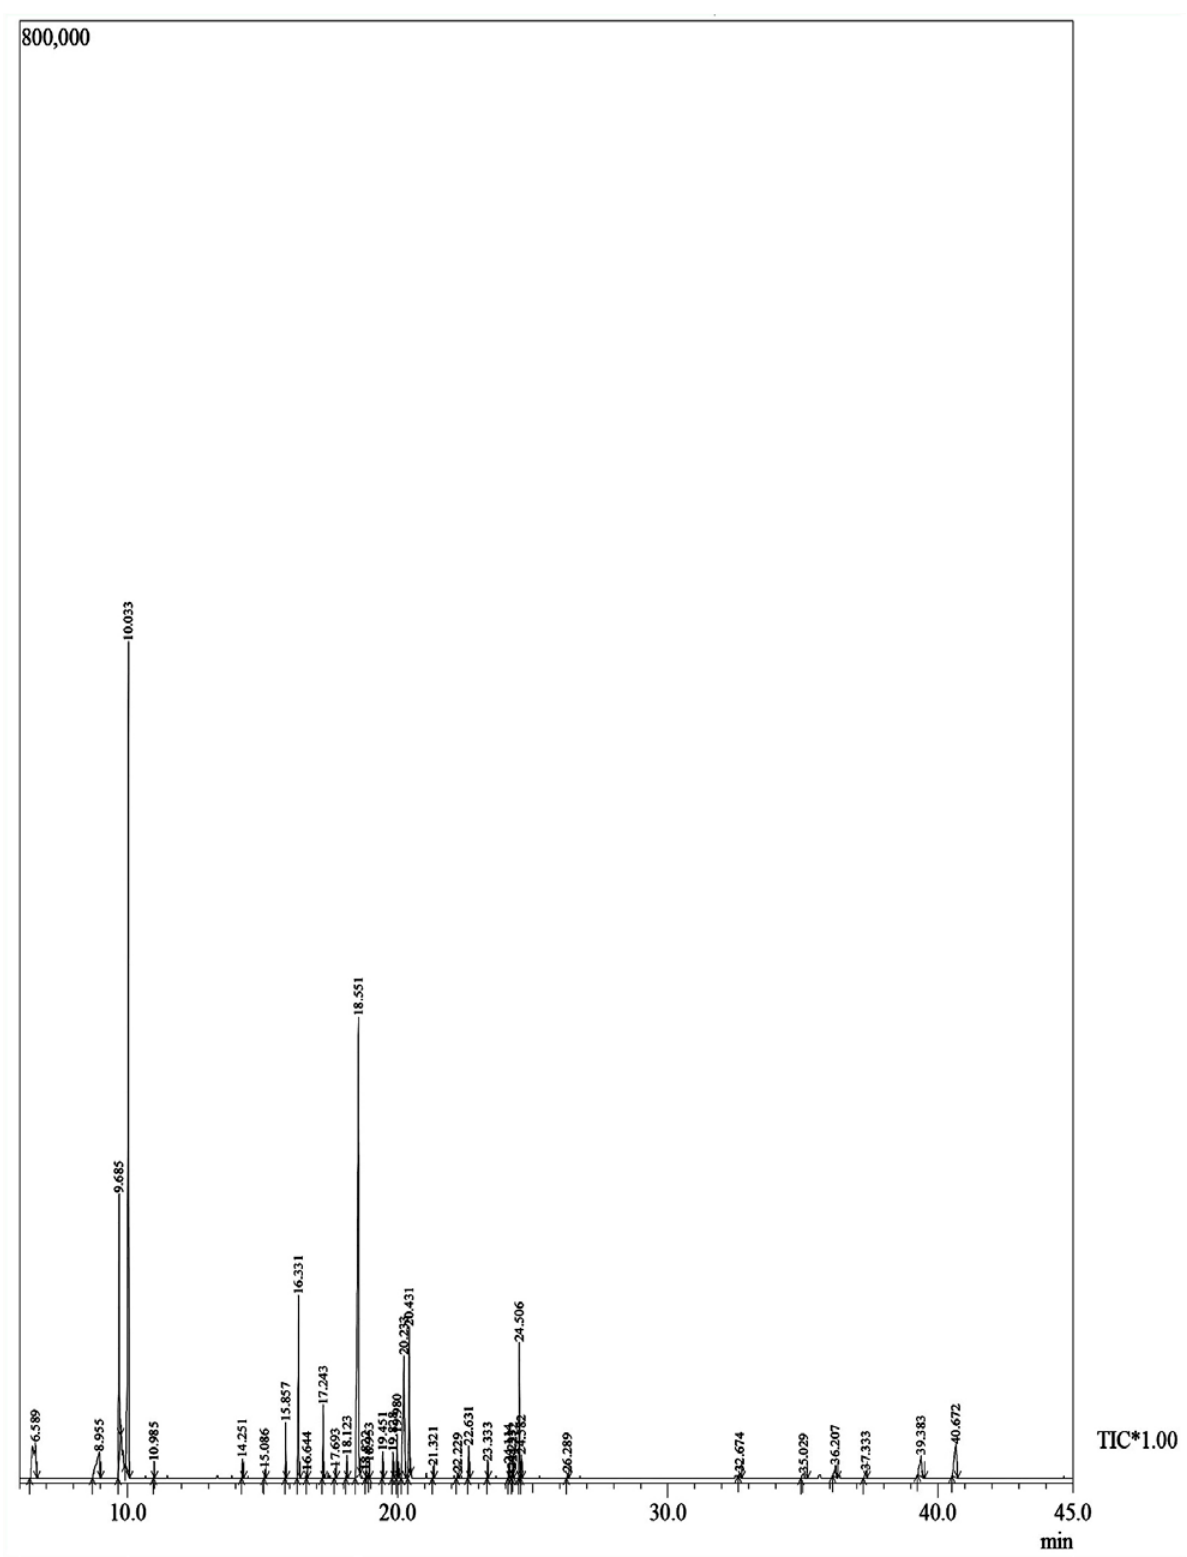
Fig. 1. GC chromatogram of methanolic extract of C. viminale [Total ion current (TIC) chromatogram]